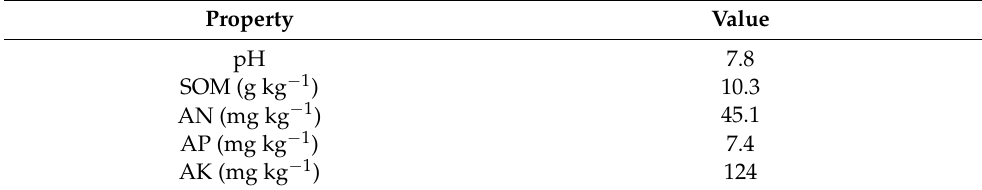
Table 1. Selected soil chemical properties in the experimental